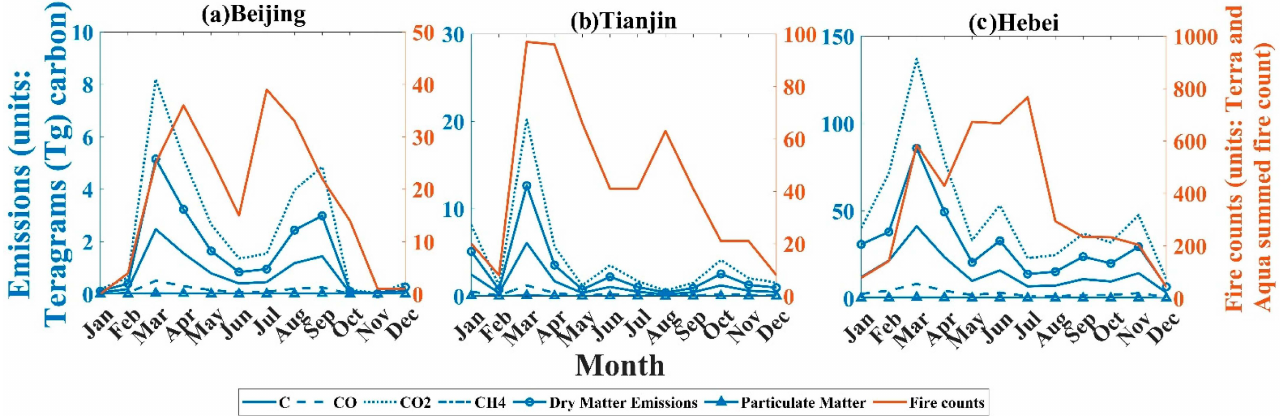
Figure 8. Estimate of monthly carbon, carbon monoxide, carbon dioxide, methane, dry matter, and particulate matter emissions caused by fires in